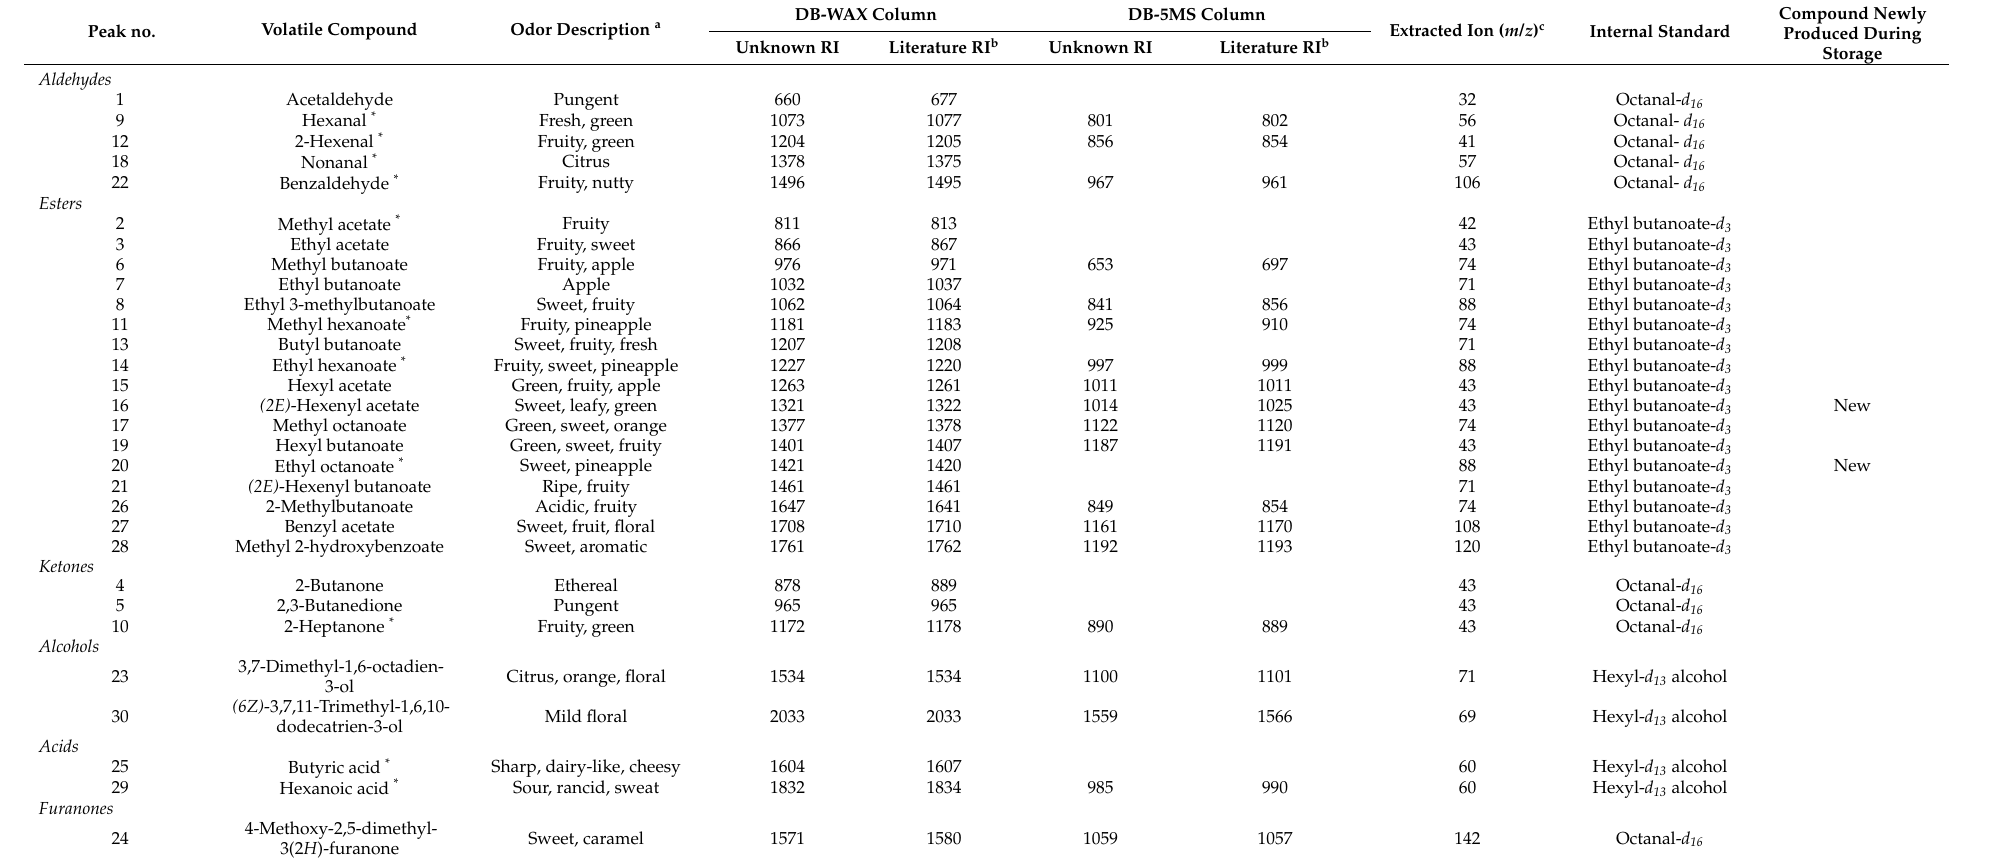
Table 1. Volatile compounds identified using HS-SPME-GC/MS in